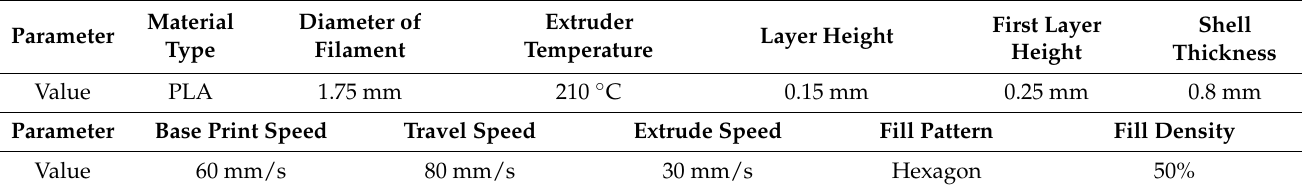
Table 4. Parameters of 3D printing for prototype construction.